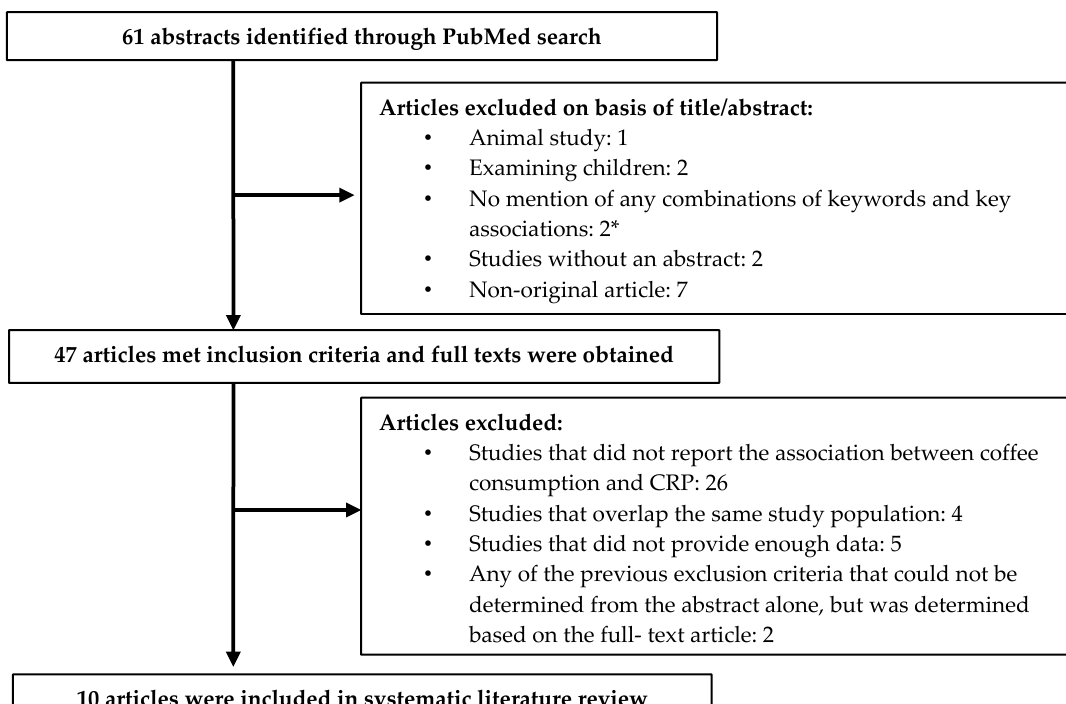
Figure 1. Flow chart of systematic literature revie w. *(A) no mention of coffee or other beverages, or of associations between food or beverage intake other than coffee and c-reactive protein (CRP) or other inflammatory biomarkers; (B) no mention of CRP or other inflammatory markers/biomarkers, or of associations between beverage consumption and outcome variables other than CRP.